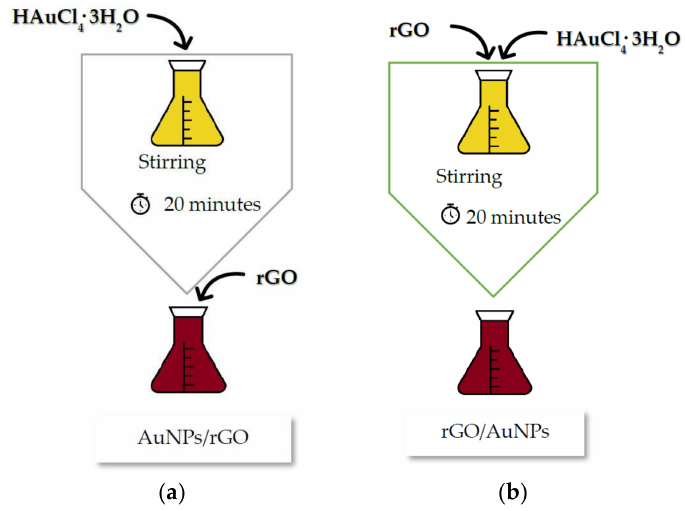
Figure 12. Preparation of samples by SQ1-AuNPs/rGO ( a ) or SQ2-rGO/AuNPs ( b